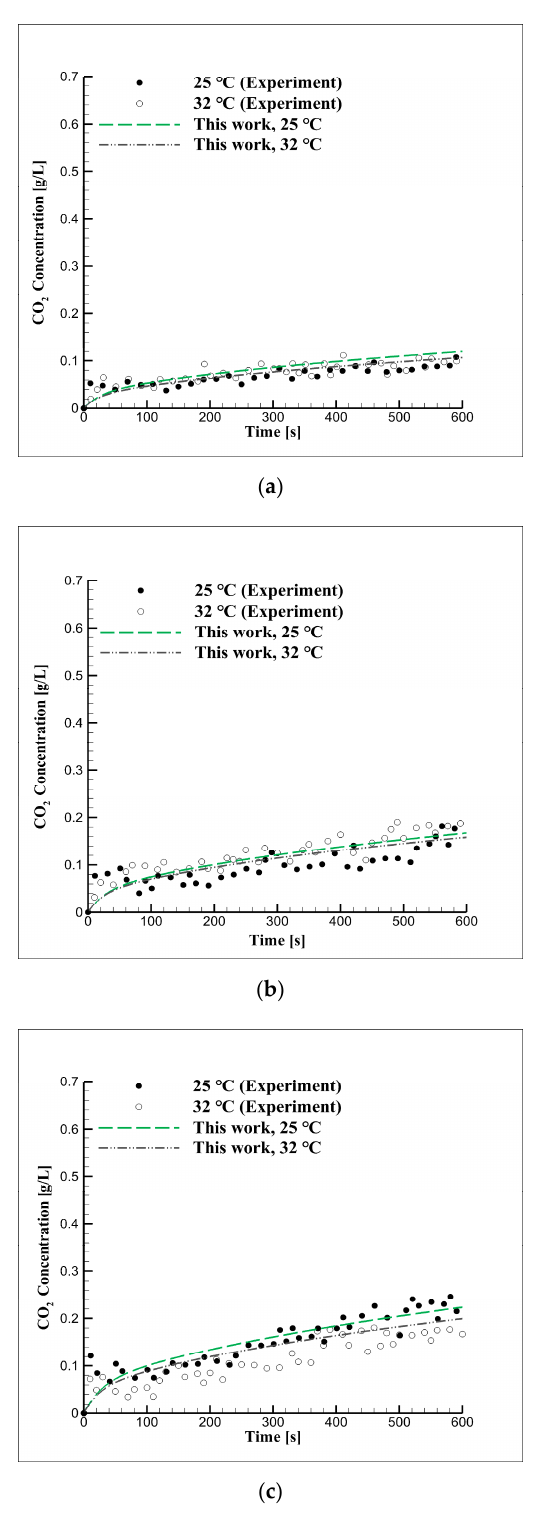
Figure 6. Mid-term CO 2 concentration over time due to changes in equilibrium pressure and Figure6. Mid-termCO 2 concentrationovertimeduetochangesinequilibriumpressureandtemperature temperature in seawater at pressures of ( a ) 2, ( b ) 3, and ( c ) 5 bar. in seawater at pressures of ( a ) 2, ( b ) 3, and ( c ) 5